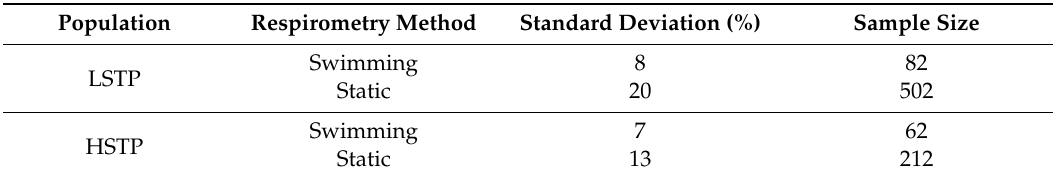
Table 3. Analyses of the estimated sample size needed to detect a cost of osmoregulation of 5% SMR in the current study. The statistical power cut-o ff value was set to 0.8. The analyses were done for both swimming and static respirometry determinations of standard metabolic rate (SMR) on European perch ( Perca fluviatilis ) from a low salinity tolerance population (LSTP) and a high salinity tolerance population